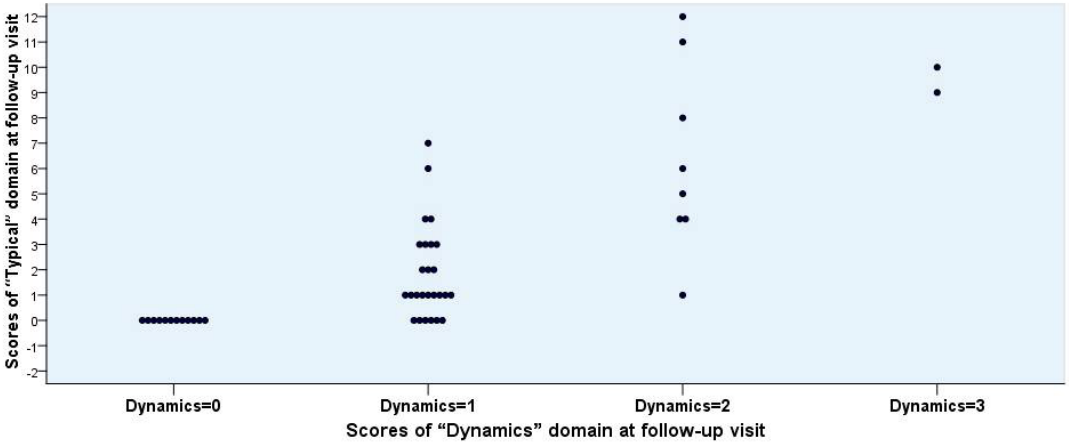
Figure 2. Individual scores for “Typical” versus “Dynamics” domain obtained from 48 female patients at the follow-up visit.